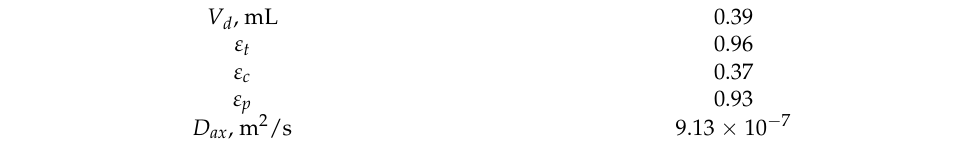
Table 5. The column parameters as evaluated through the procedure described in [40].